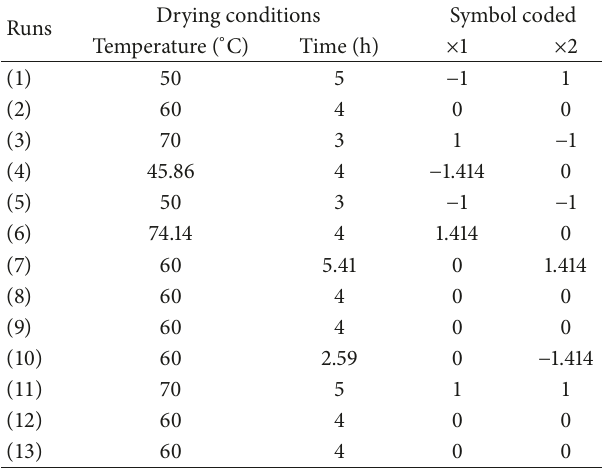
Table 2: Independent variables and their coded values used for